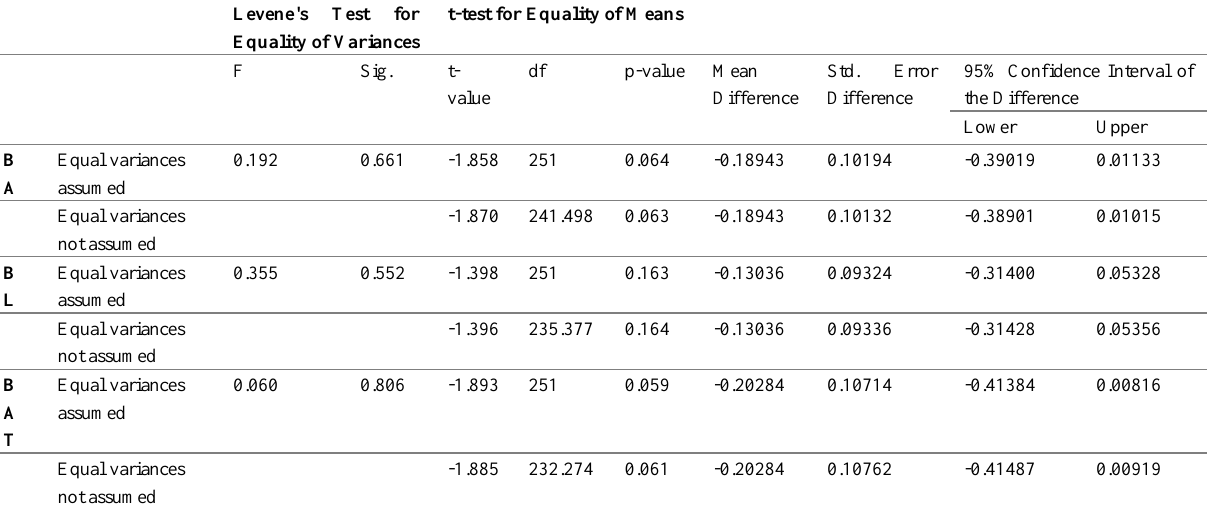
Table 9: Independent sample t-test